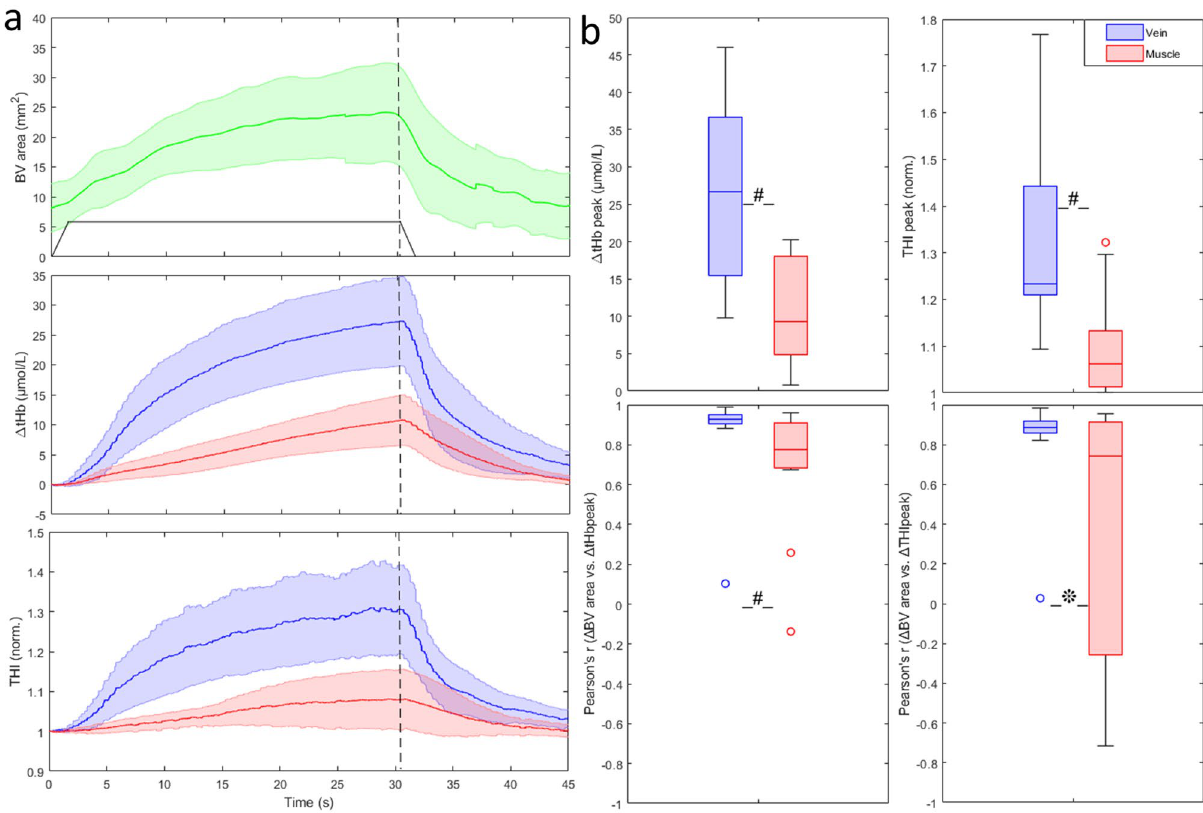
Figure 4. Average response to rapid venous occlusion of the cross-sectional area of the basilic vein (green) and of tHb and THI as detected on the muscle (red) and on the vein (blue). Shaded areas represent the 95% confidence interval of the mean. The black trapezoid depicted in the top graph qualitatively reproduces the cuff pressure during inflation to 40 mmHg, plateau and subsequent deflation to 0 mmHg, while the vertical dashed line indicates the beginning of deflation. ( b ) Peak response of blood volume indexes, collected from vein and muscle probes (top), Pearson’s coefficient of the correlation between changes in BV cross-sectional area and in blood volume indices (bottom). *p < 0.05; # p <